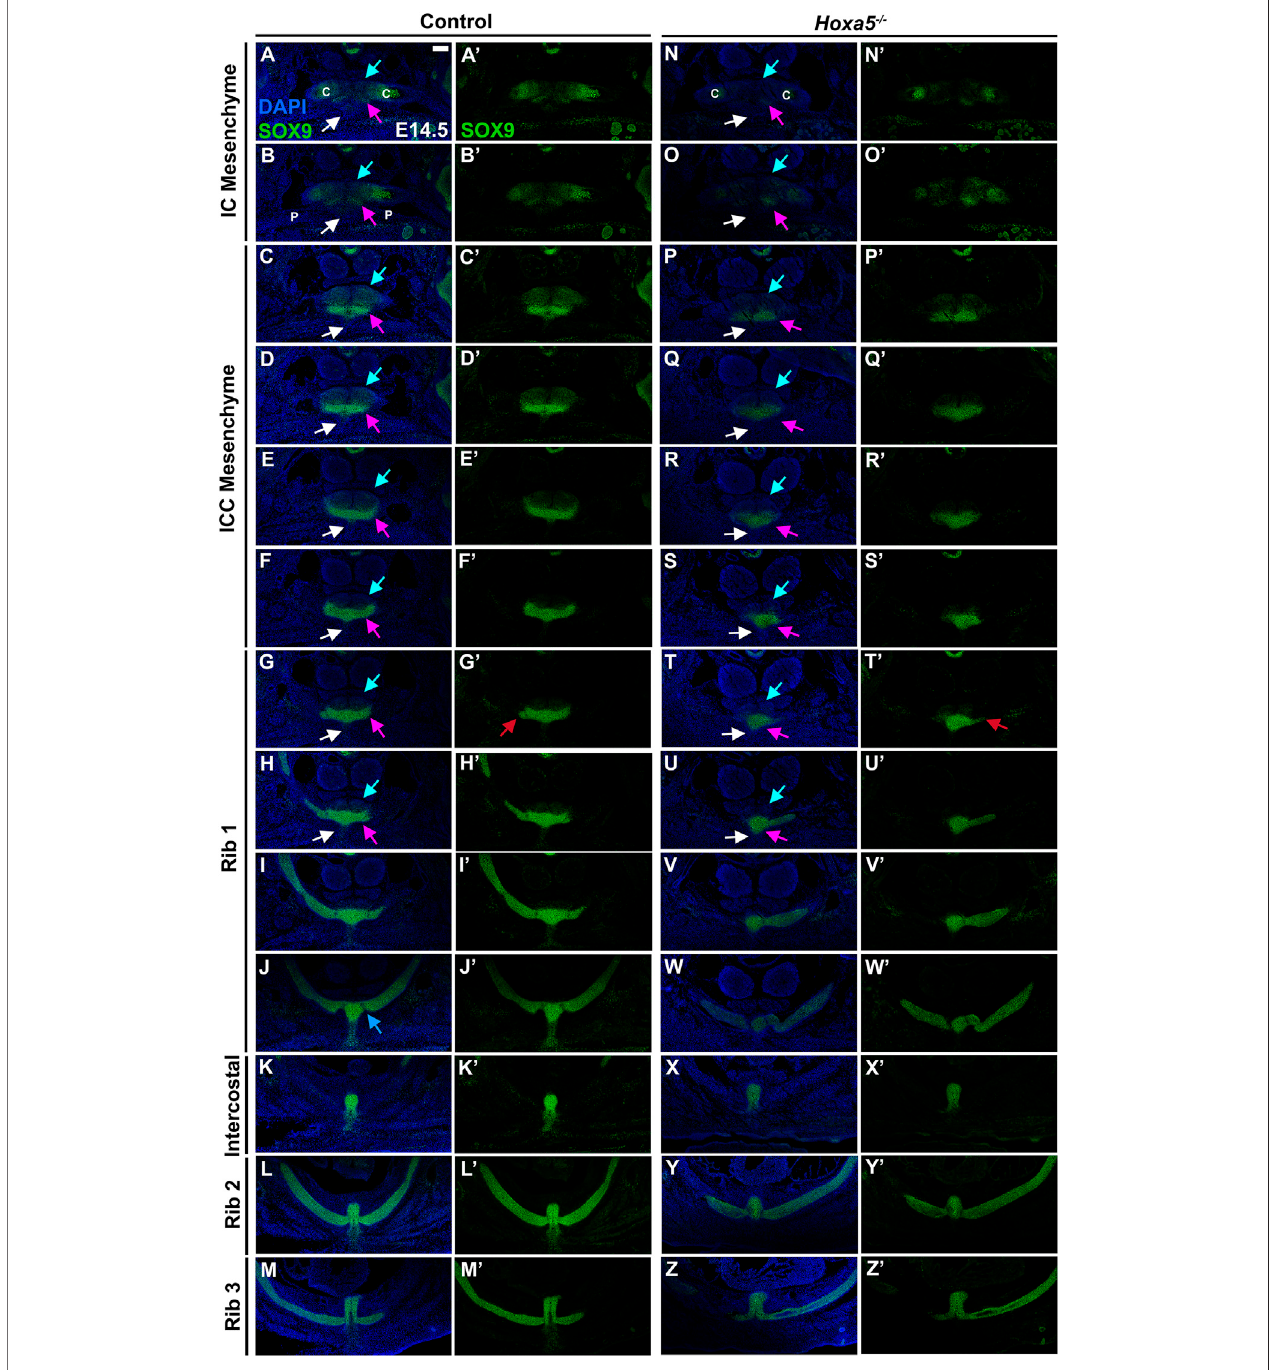
FIGURE4| Developmentofthepresternumisdisruptedin Hoxa5 nullmutants. (A – M 9 ) SOX9expression,shownwith (A – M) andwithout (A 9 – M 9 ) DAPIlabelling,in serial sections from the anterior presternum through T1 – T3 attachments of an E14.5 WT embryo. (N,N 9 – Z,Z 9 ) SOX9 expression in serial sections through the presternumandT1 – T3attachmentofaHoxa5 − / − nulllittermate. (A – H) and (N – U) BluearrowsmarkdorsalIC/ICC;pinkarrowsindicateventralICC;whitearrowspointto the site of pectoral muscle attachment. Red arrows in G ′ and T ′ indicate fi rst contact of T1 with the sternum. Blue arrow in J indicates the beginning of the second contact of T1 with the sternum. Scale bar: 200 μ M. C, clavicle; IC, interclavicular; ICC, intercostoclavicular; P, pectoral muscle.